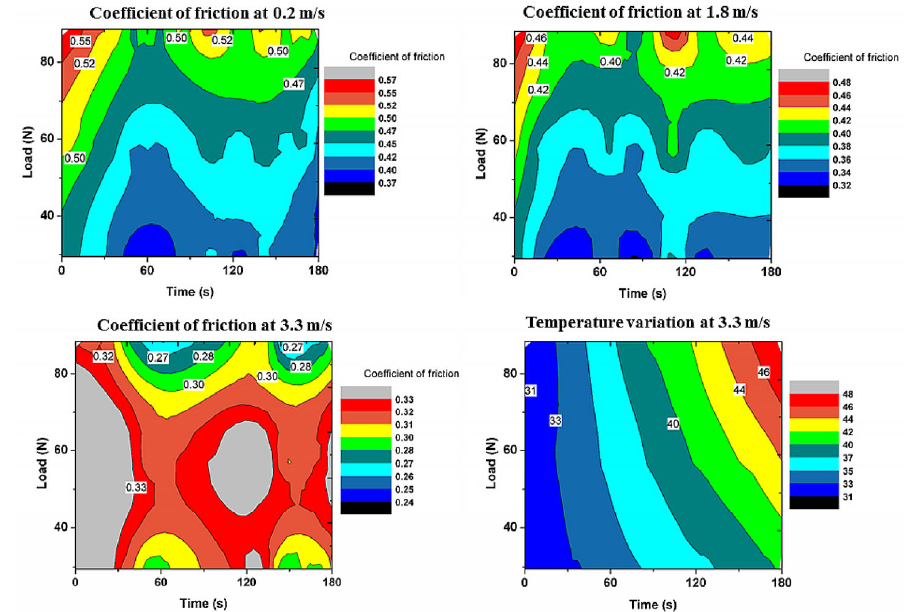
Fig. 7 Variation of the coefficient of friction and temperature for W-III composition.